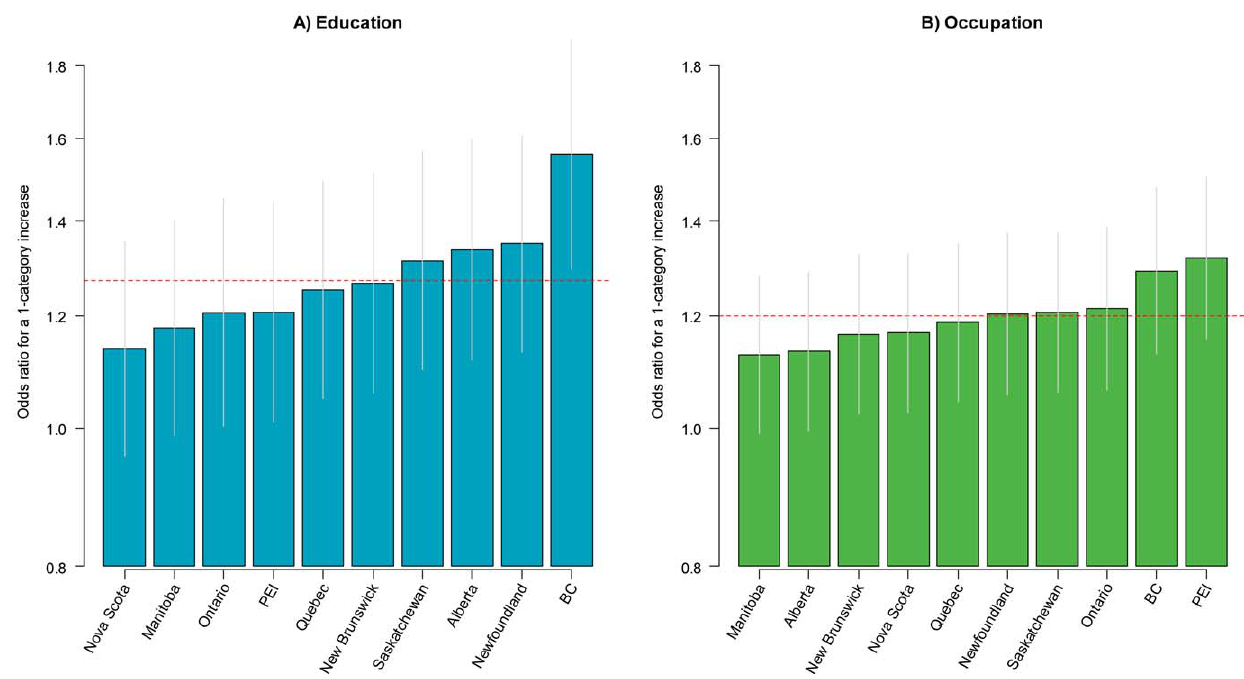
Figure 6. Odds ratios for quitting for a one-category increase in the level of education and occupation across Canadian provinces. BC British Columbia; PEI Prince Edward Island.